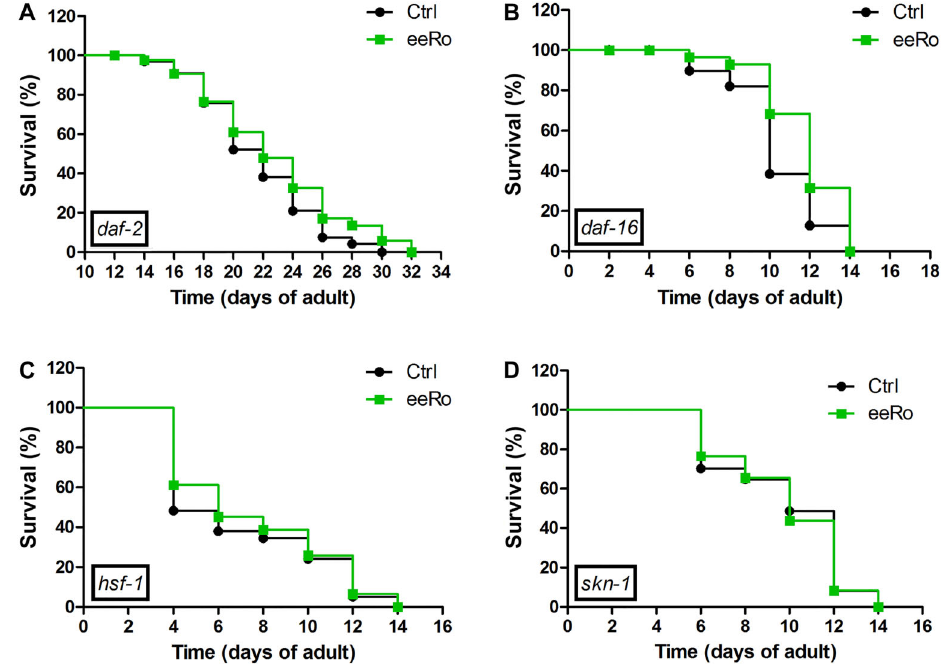
Figure 5. Effect of 25 m g/mL ethanolic extract of Rosmarinus of fi cinalis L. (eeRo) in ( A ) daf-2 , ( B ) daf-16 , ( C ) hsf-1 and ( D ) skn-1 mutants lifespans. Survival curves were signi fi cantly different in daf-16 (median lifespan) and in daf-2 (maximum lifespan) (P o 0.05, log-rank (Mantel-Cox) test).